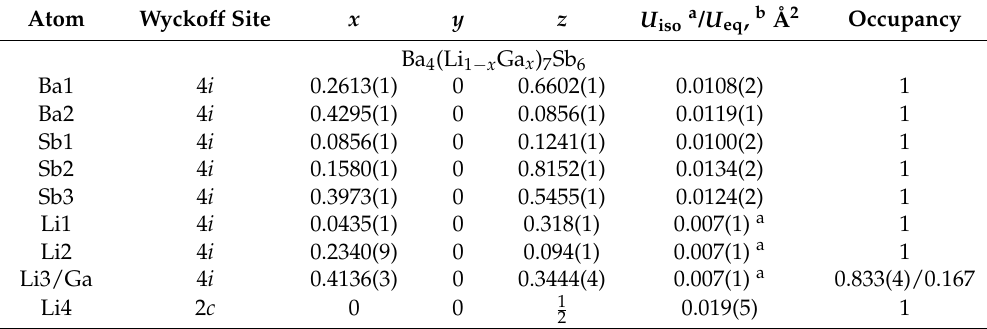
Table 7. Final refined positional coordinates and displacement parameters for AE 4 (Li 1 − x Ga x ) 7 Pn 6